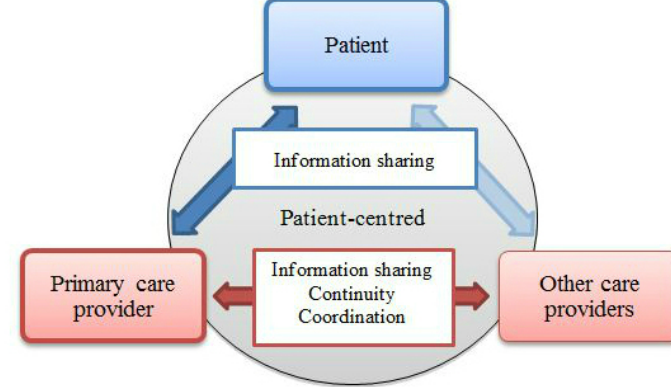
Figure 1. Needs framework for community-dwelling patients with CCDD in our study.